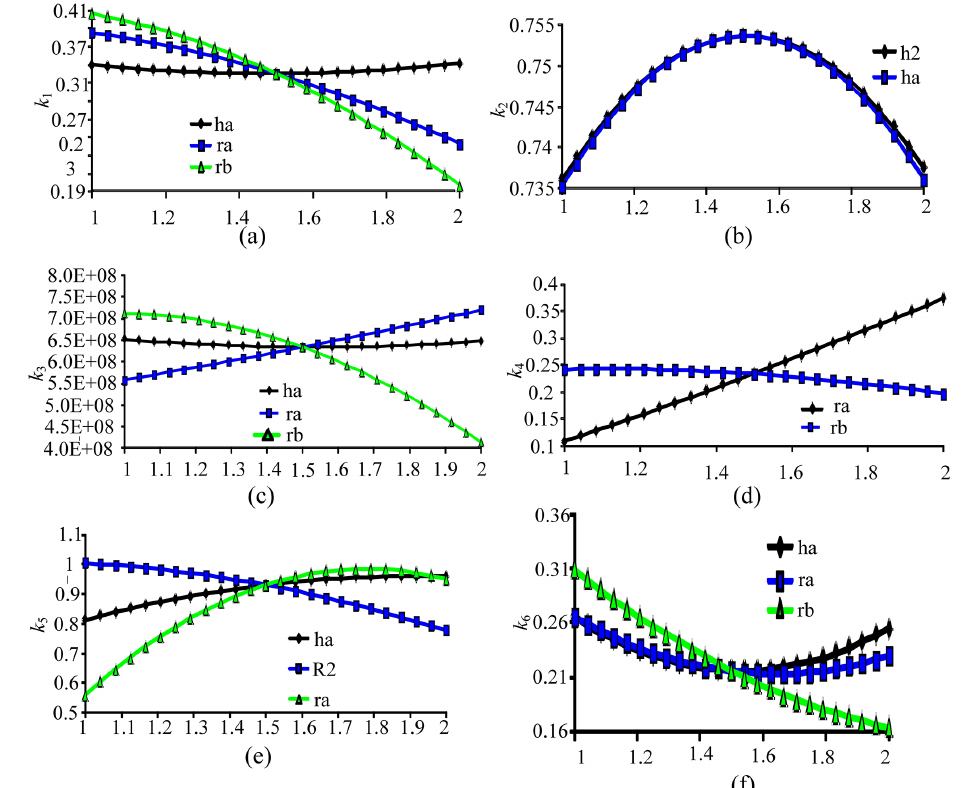
Figure 5. Main effect diagram of the different objective